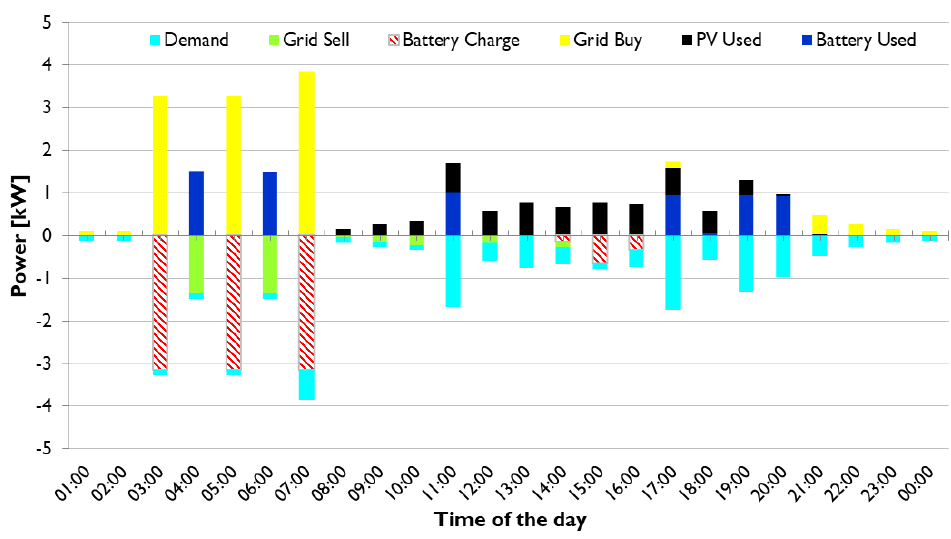
Figure 10. Power balance of the proposed hybrid system for a sample summer case.